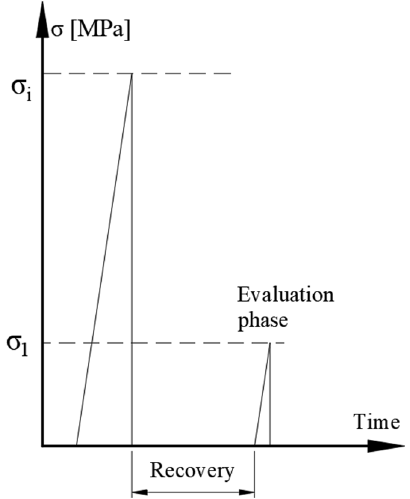
Figure 3. Load cycle with evaluation phase. Table 1. Parameters for RPL tests. Cycle No.